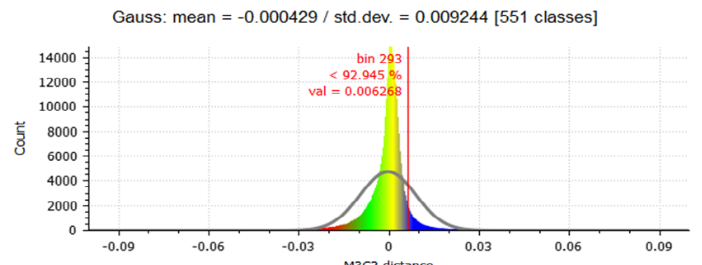
Figure 6. The numerical result of distance discrepancy between multispectral and TLS point